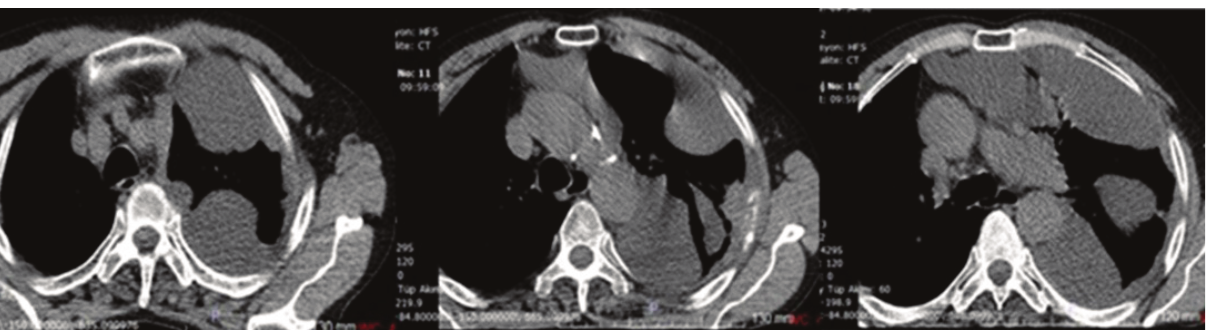
Figure 1: Posteroanterior chest radiographs of patient. (a) On admis- sion. (b) After six cycles of chemotherapy.